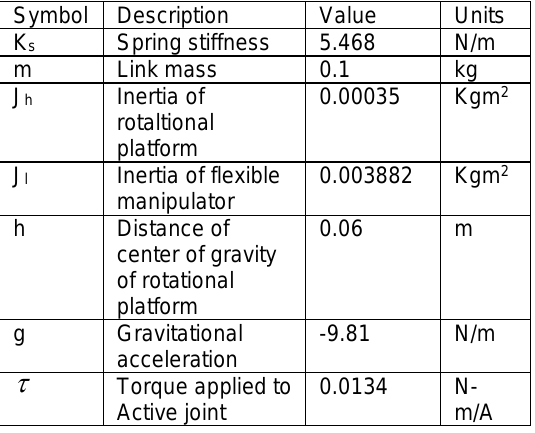
Figure 2 . Schematic diagram of flexible joint robotic arm. Table 1. Parameters of flexible joint